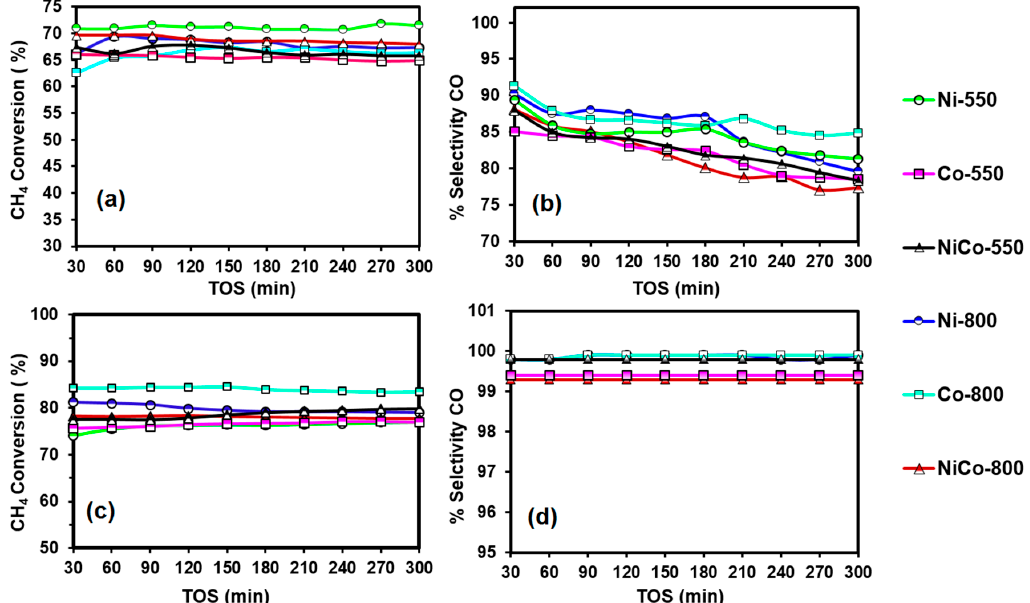
Figure 8. ( a ) CH 4 conversion and ( b ) CO selectivity with time on stream in POM over Ni and/or Co-based catalysts at 700 °C; ( c ) CH 4 conversion and ( d ) CO selectivity with time on stream in POM over Ni and/or Co-based catalysts at 800 °C.